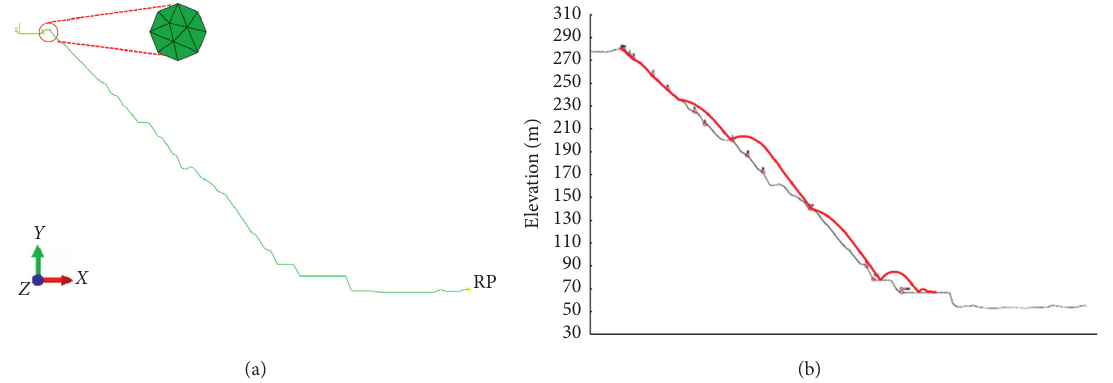
Figure 5: Numerical simulation: (a) mesh for simulation; (b) simulation result.